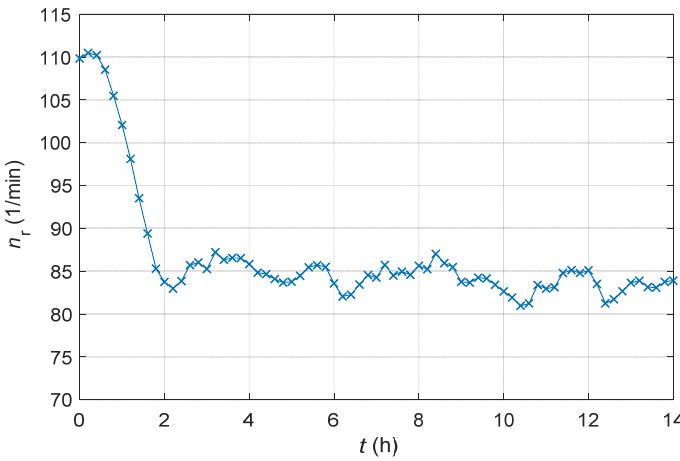
Figure 8. Time course of the reference signal n r for the stirrer system of the laboratory batch bioreactor with an AMFC system (i.e., output of AMFC controller).